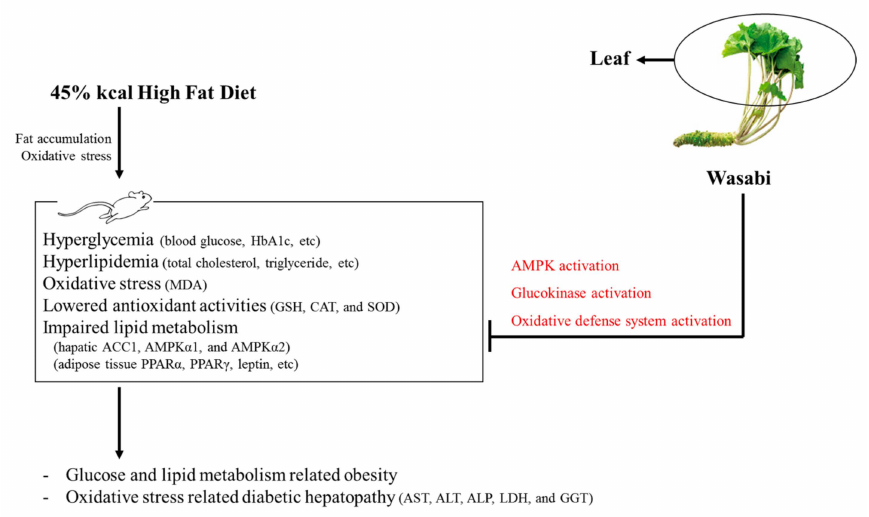
Figure 10. The comprehensive results of Wasabi Leaf against diabetic obesity in the present study. HbA1c = Glycated hemoglobin; MDA = Malondialdehyde; GSH = Glutathione; CAT = Catalase; SOD = Superoxide dismutase; ACC1 = Acetyl-CoA carboxylase 1; AMPK = 5’ adenosine monophosphate-activated protein kinase; PPAR = Peroxisome proliferator-activated